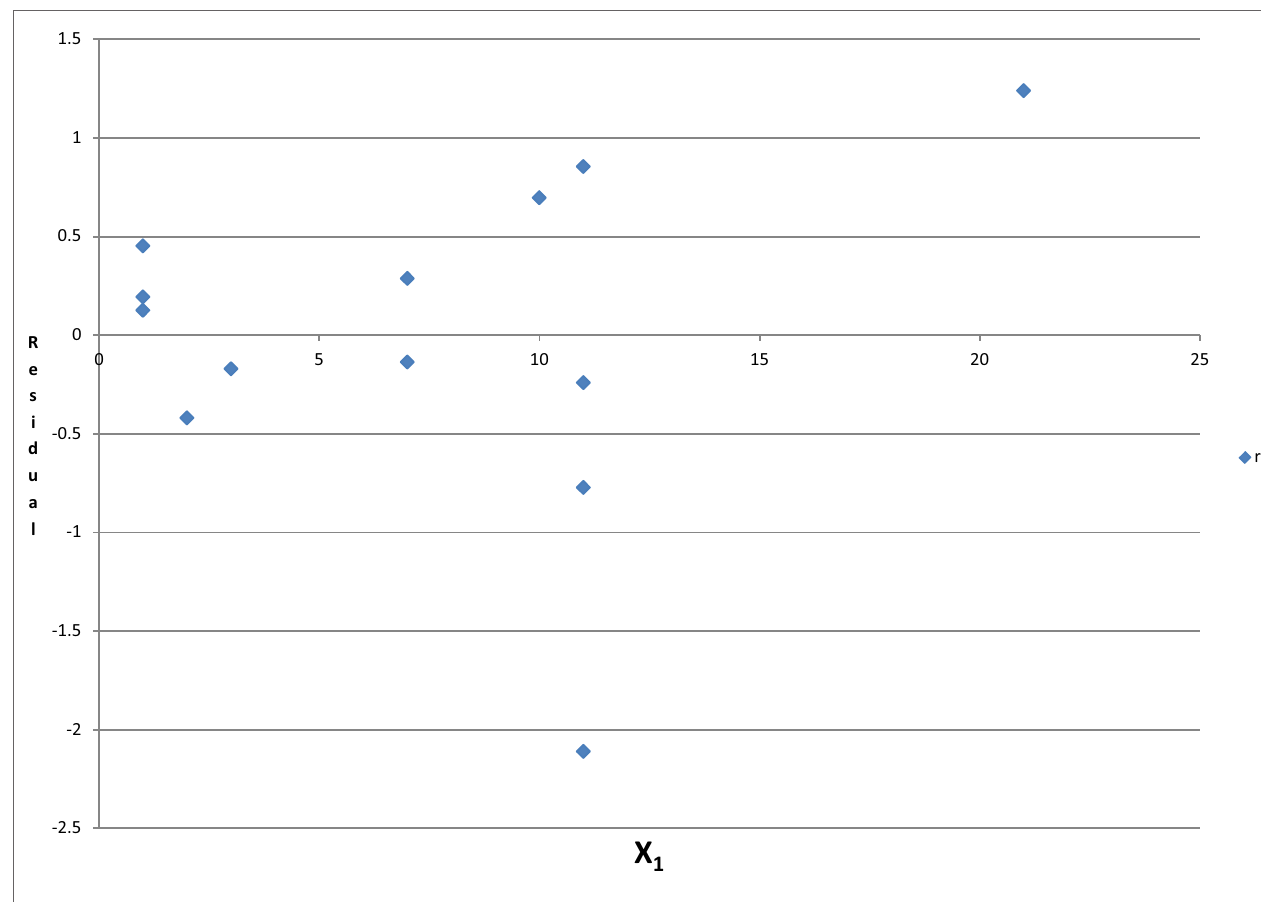
FiGURe 3 | The unexplained information of X 1 and X 1 by controlling for X 2 , X 3 , and X 4 .